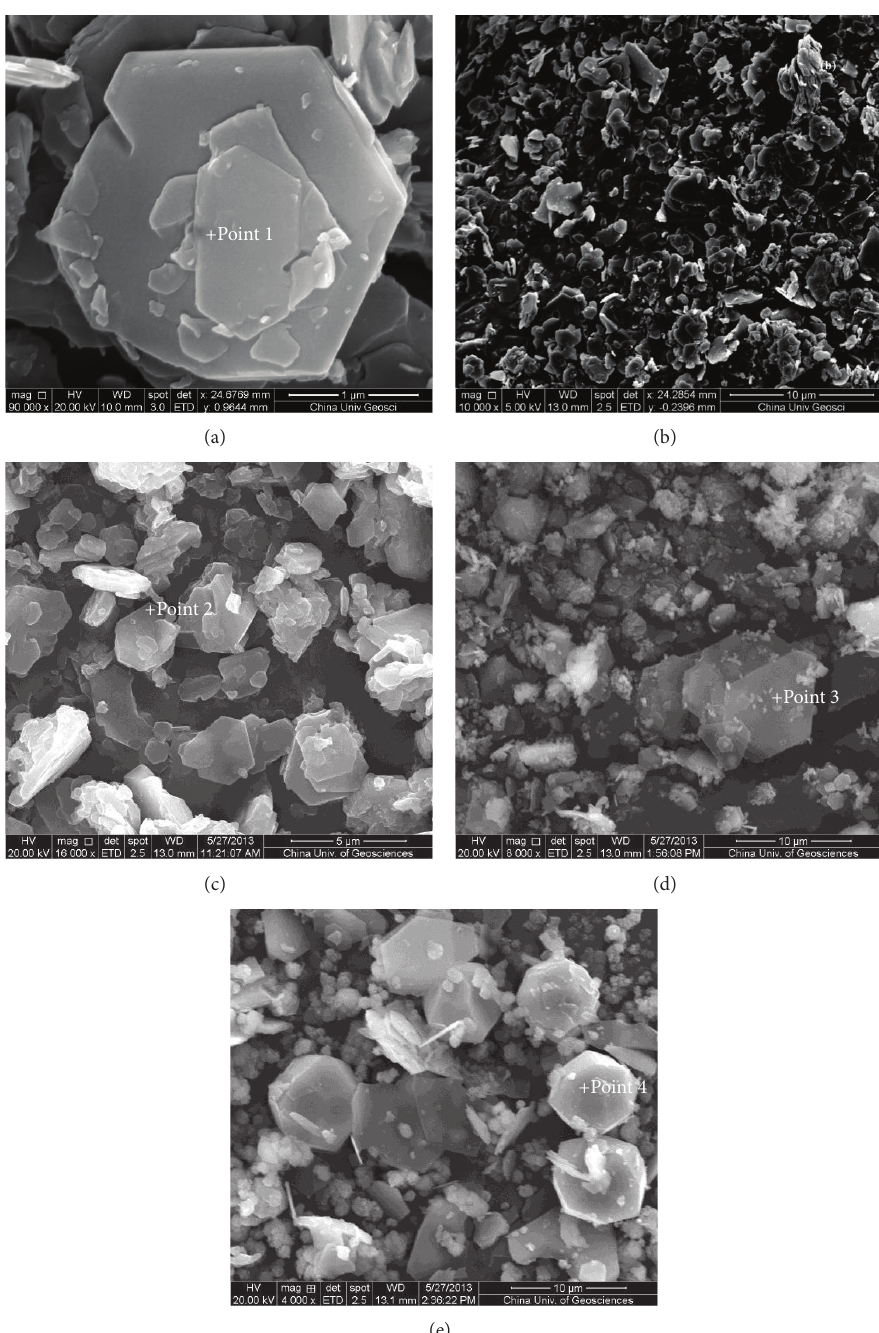
Figure 4: SEM images of original hydrocalumite at two different magnifications (a and b) and the rehydrated products of calcined hydrocalumite at 400 ∘ C (c), 1000 ∘ C (d), and 1500 ∘ C (e).